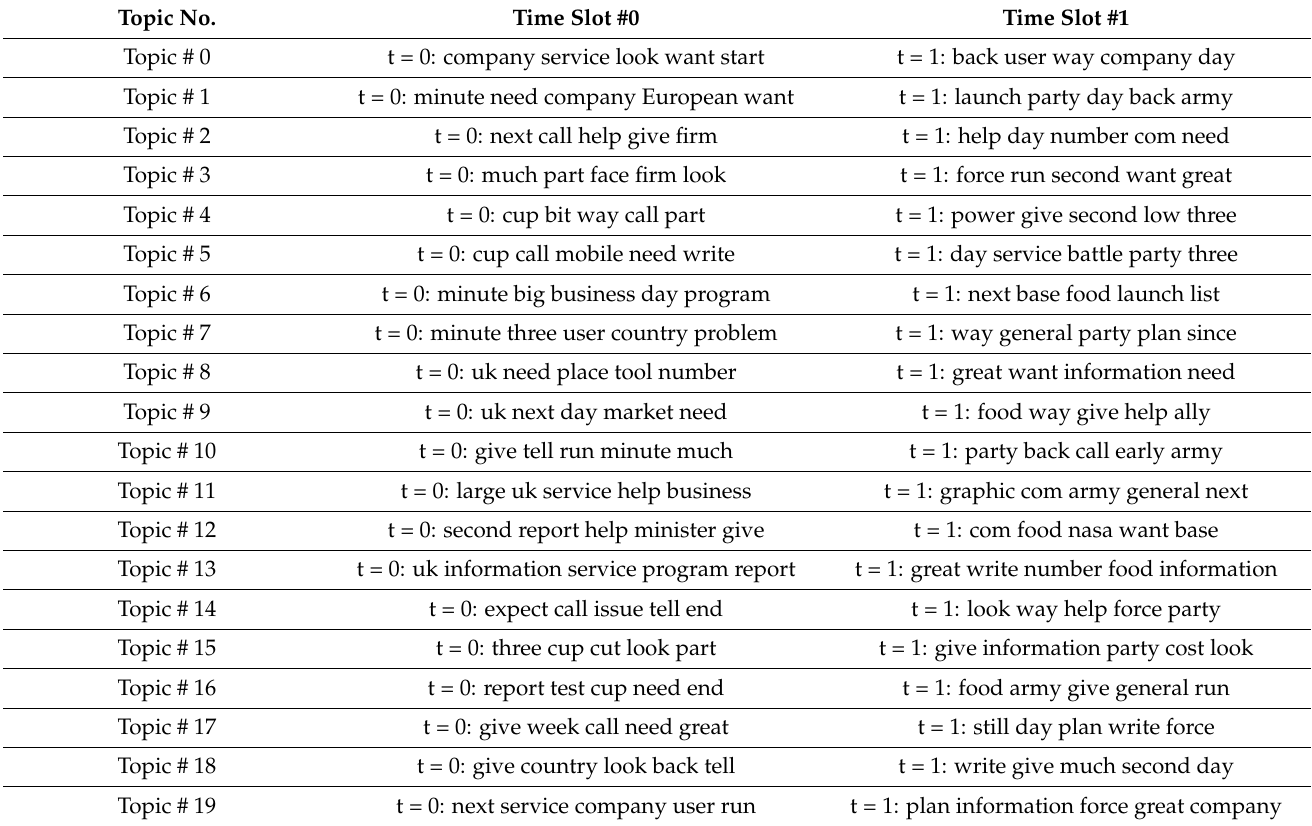
Table 3. DTM results for 10 Newsgroups dataset.